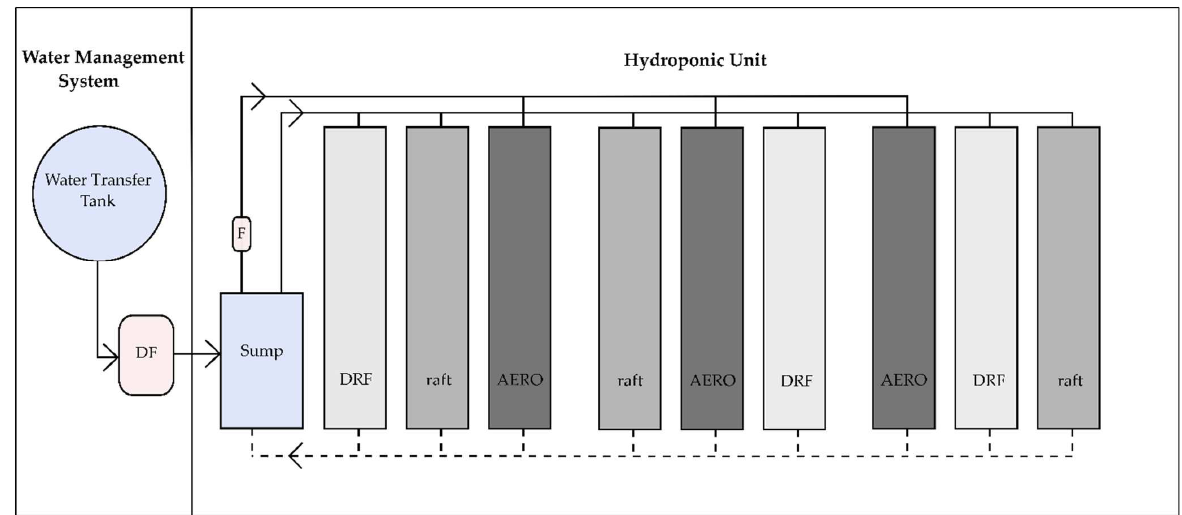
Figure 1. Schematic illustration of the decoupled experimental hydroponics cycle with DRF, raft, and AERO hydroponic subsystems in cabin 1_05 of the FischGlasHaus. DF: drum filter; F: filter. Aquaculture effluent water from C. gariepinus production was pumped to the water transfer tank.